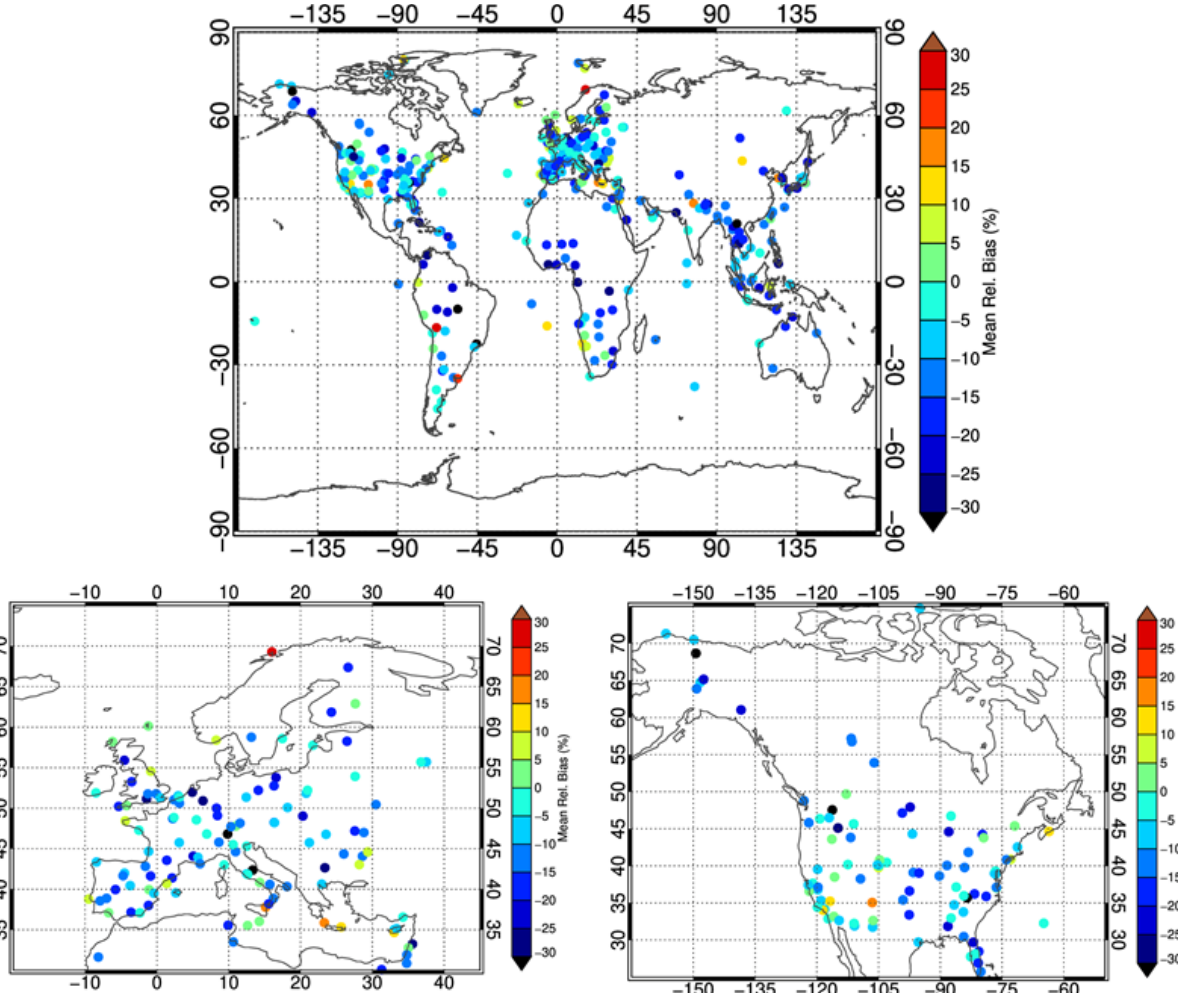
Figure A1. The mean relative bias (in%) between satellite- and ground-based observations per station in the form of a world map (above). The two panels below show the areas that are very well populated with stations in Europe (left panel) and North America (right panel) in greater